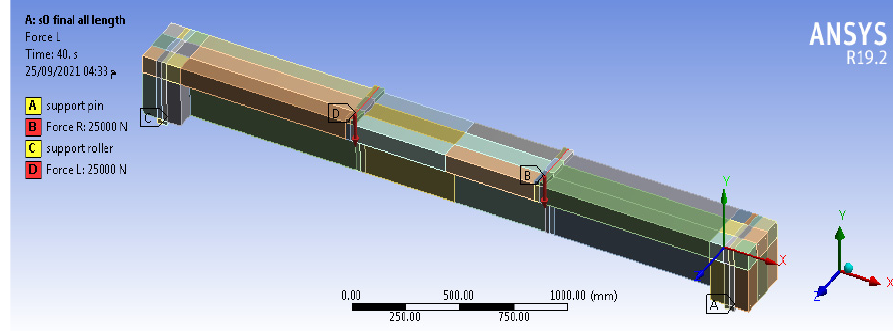
Figure 5. The FE applied loads for specimens.